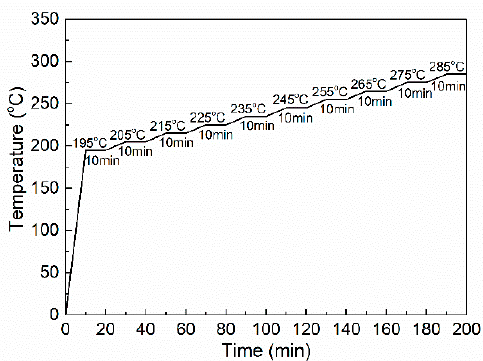
Figure 1. Heat treatment program for thermal stabilization of PAN and PAN copolymer nanofibers.